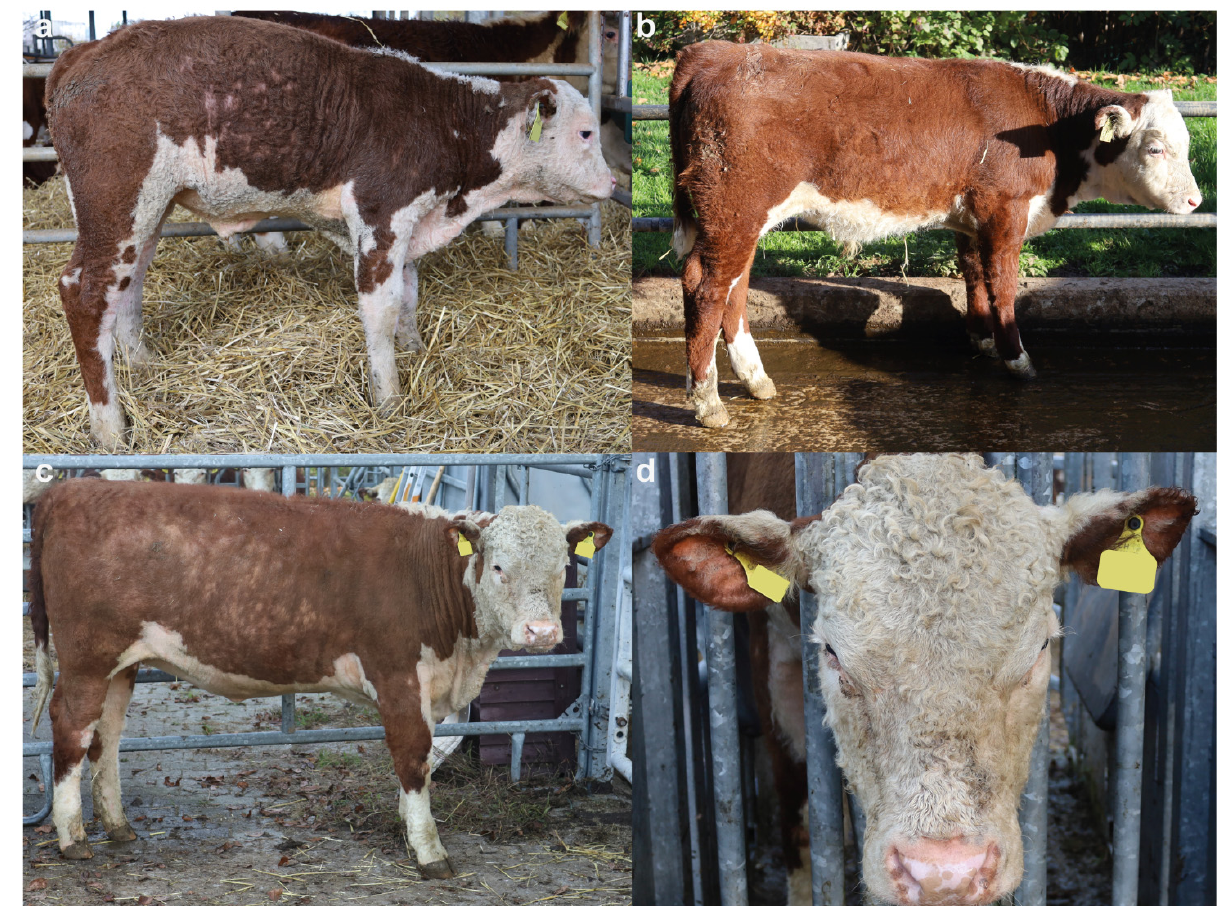
Figure 1. Congenital hypotrichosis in Hereford cattle. ( a ) Case 1: note the short, fine, wooly, kinky and curly hair, particularly in the thoracic-abdominal region. ( b ) Healthy control: 2-month-old Hereford calf with a normal coat. ( c ) Case 2: note the short, fine, wooly, kinky and curly hair, which is more severe than in case 1. ( d ) Case 2: note the evident curly hair in the head and the short, fine and kinky hair in the ears.